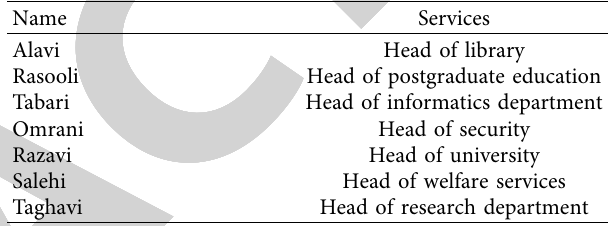
V, A, B . (cid:27) ( ) Table 2: Name of employees in a university and their